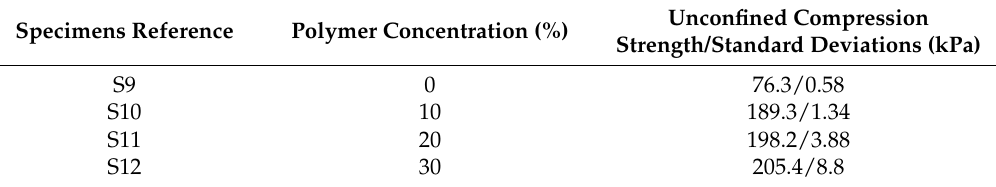
Table 3. Effect of polymer concentration on unconfined compression strength of